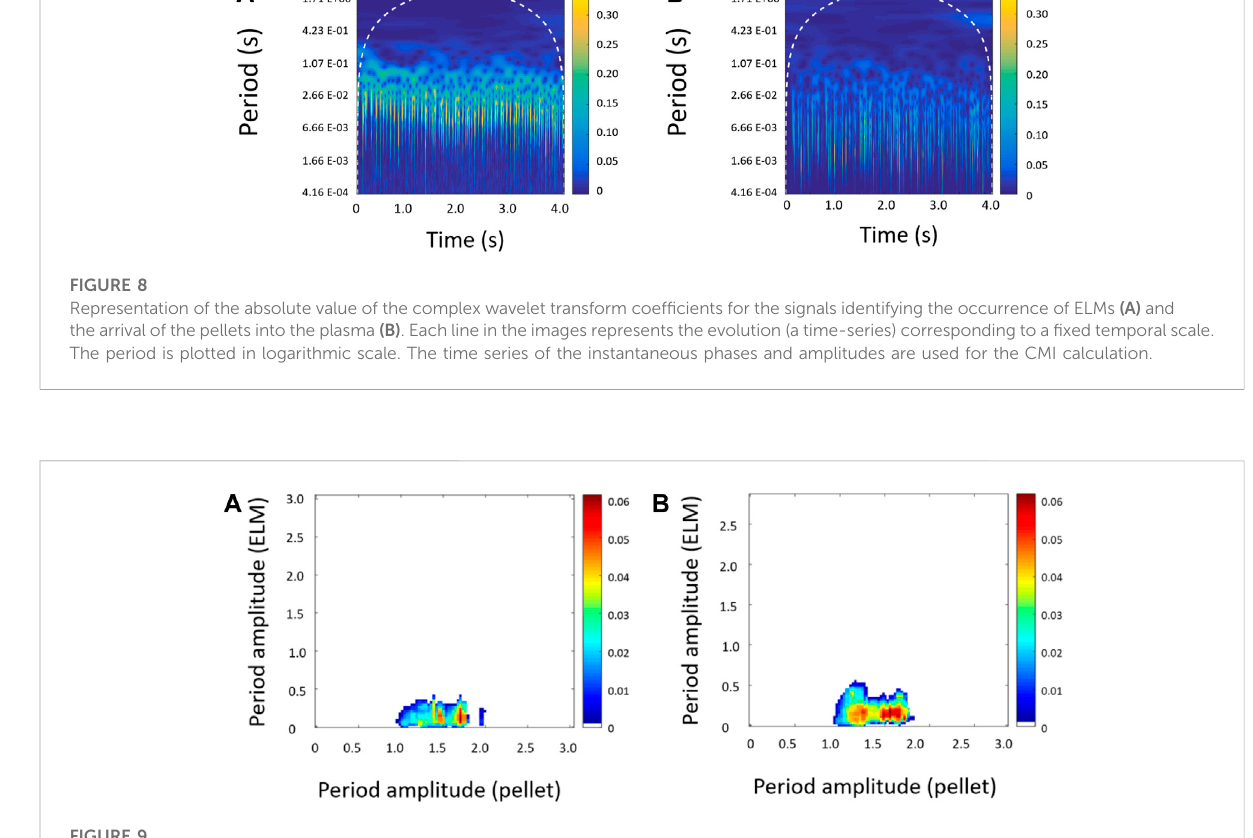
FIGURE 9 Amplitude (pellet) – amplitude (ELM) causality for the JET pulses #82885 (A) and #82854 (B) . The colour code represents the level of coupling derivedwiththeconditionalmutualinformationCMI.Forbothpulsesonlytheamplitude-amplitudecomponentofthecouplingisreported,because the others are within the uncertainties range of the method. CMI plots are shown with the period of the driver time series (pellets) on the x -axis and driven time series (ELMs) on the y -axis. Periods are measured in seconds. Shown are the positive signi fi cance-level deviations from the 99th percentile of the average CMI calculated using 50 Fourier transform